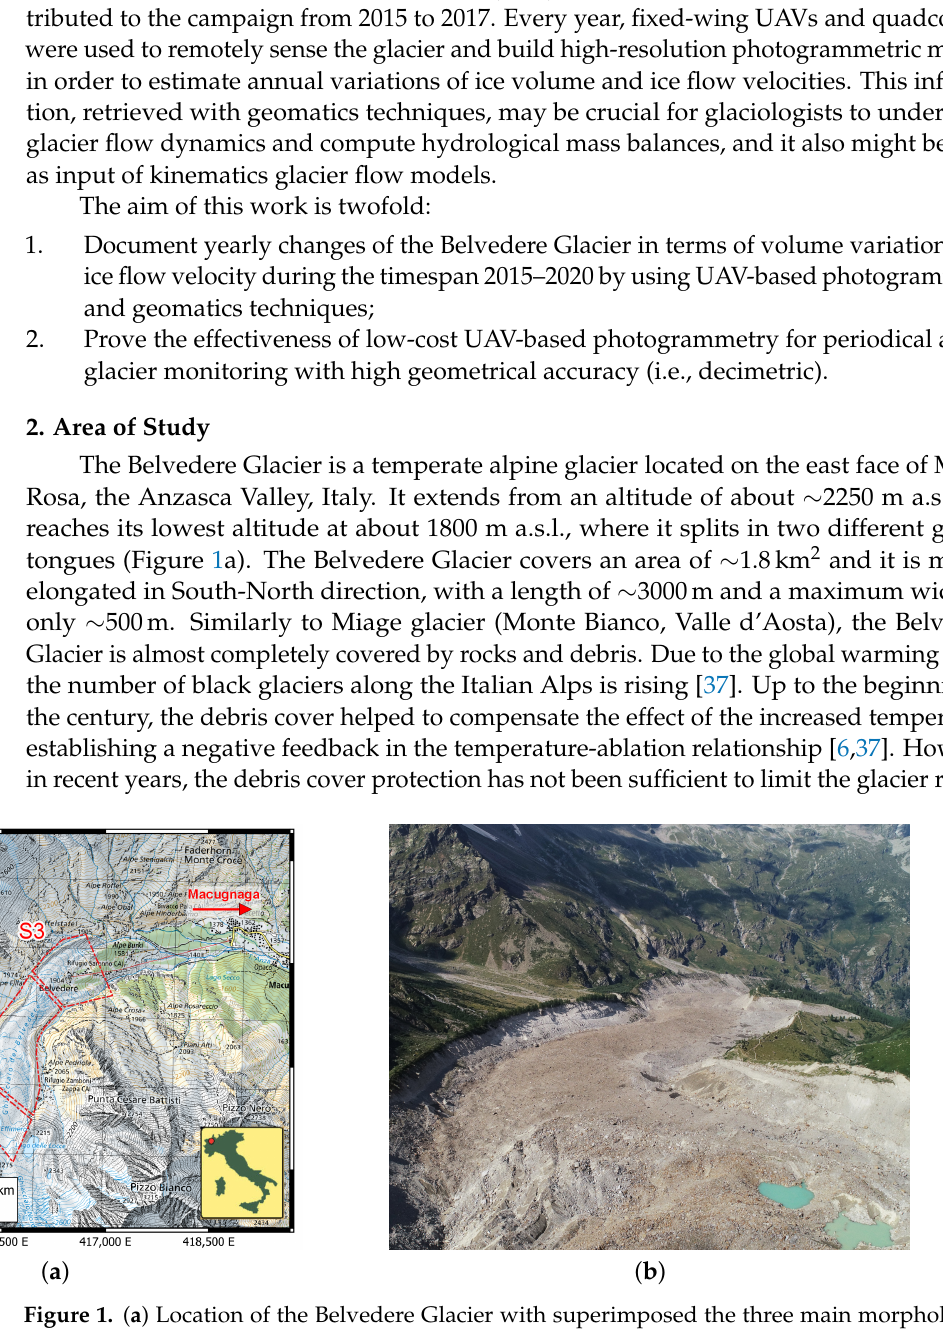
Figure 1. ( a ) Location of the Belvedere Glacier with superimposed the three main morphological sectors: sector 1 (S1) is the accumulation zone, sector 2 (S2) is the transfer zone, sector 3 (S3) is the low-relief zone with the two glacier tongues. Coordinates are framed in ETRF2000(2008)—UTM 32N. [Basemap source: Swisstopo (geo.admin.ch) ]; ( b ) Photo of the Belvedere Glacier taken by the authors during the 2020